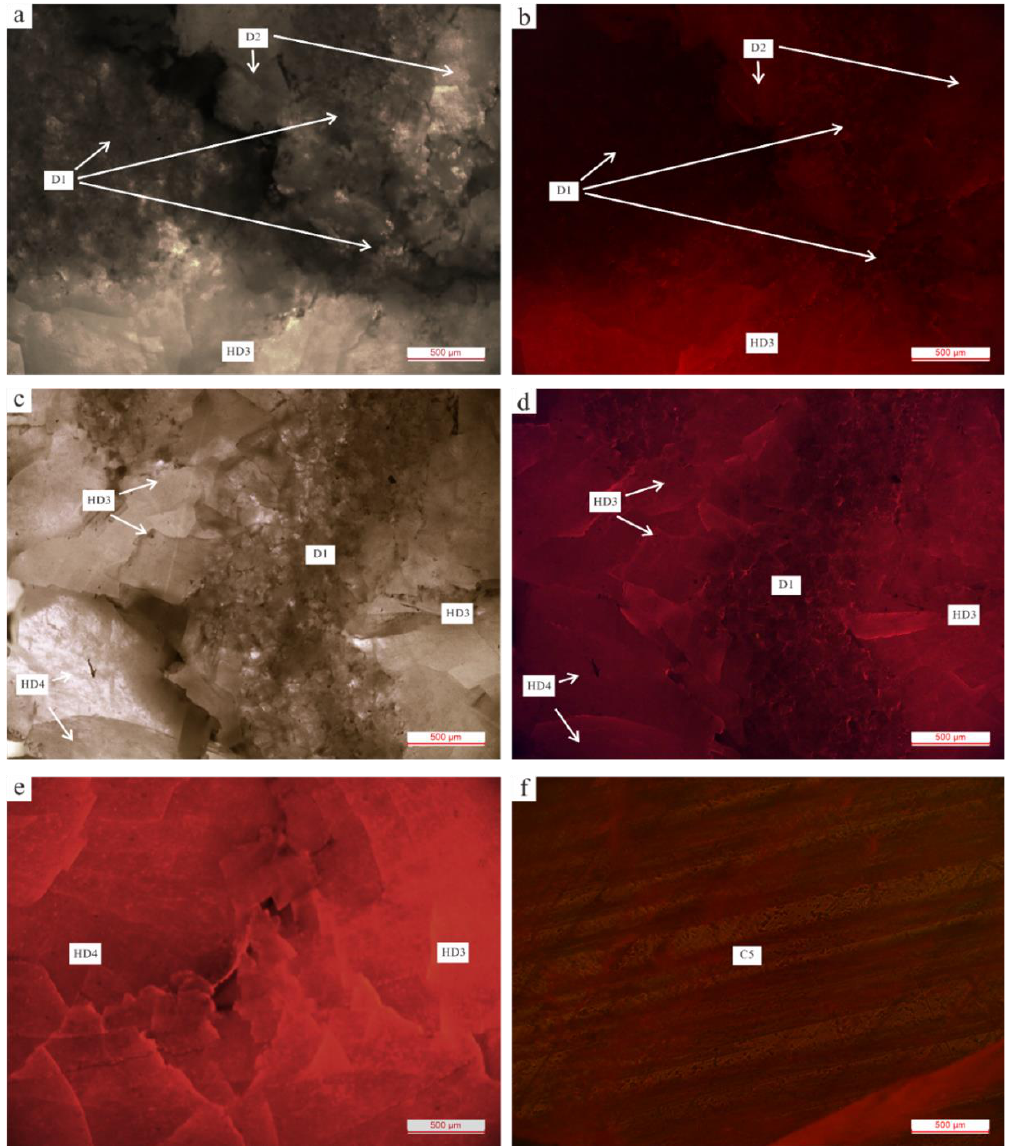
Figure 6. Transmitted light and CL images of carbonate in the Fuli Pb-Zn deposit. ( a , b ) D1 dolomite is non-luminescent, D2 dolomite presents dark crimson luminescence under CL, and HD3 grey dolomite presents bright red luminescence under CL. ( c – e ) D1 dolomite is non-luminescent under CL, HD3 grey dolomite presents bright red luminescence under CL, and HD4 white dolomite shows dark red luminescence under CL. ( f ) The euhedral calcite veins (C5) are non-luminescent under CL.